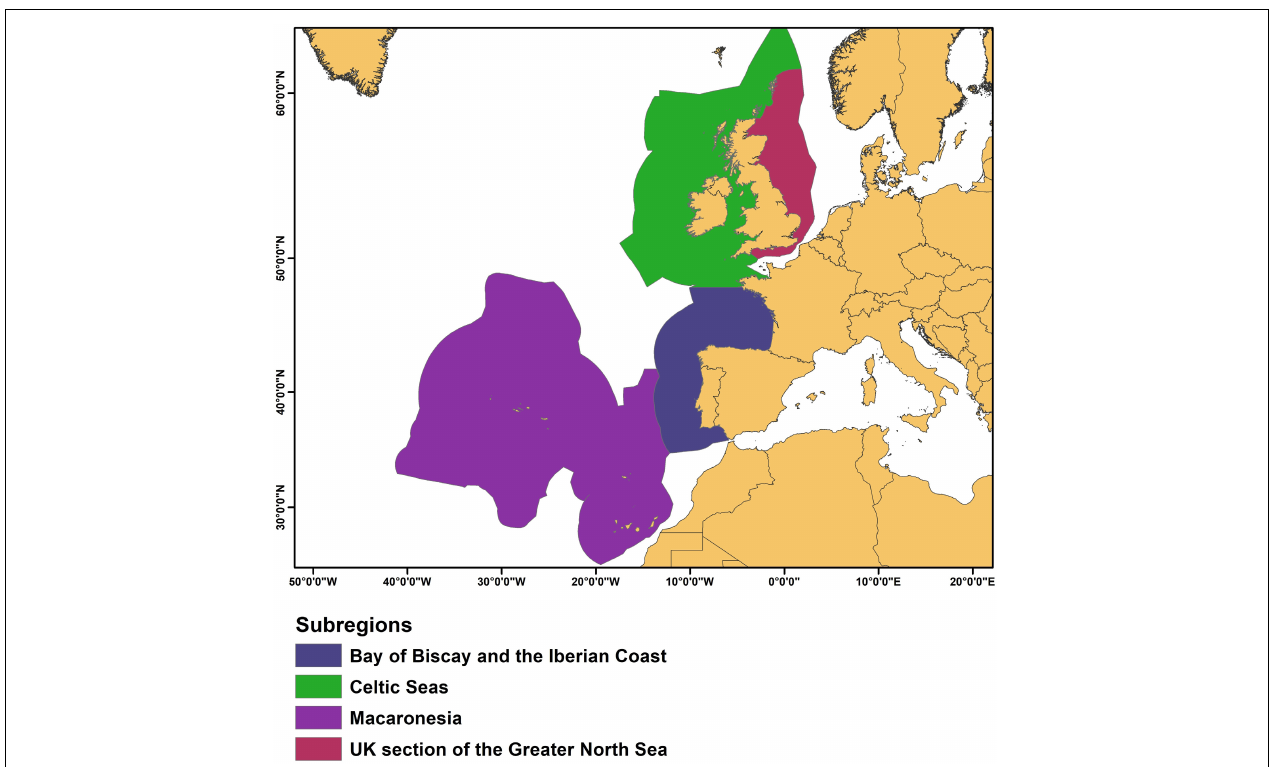
FIGURE 1 | Subregions included in the analyze (UK—United